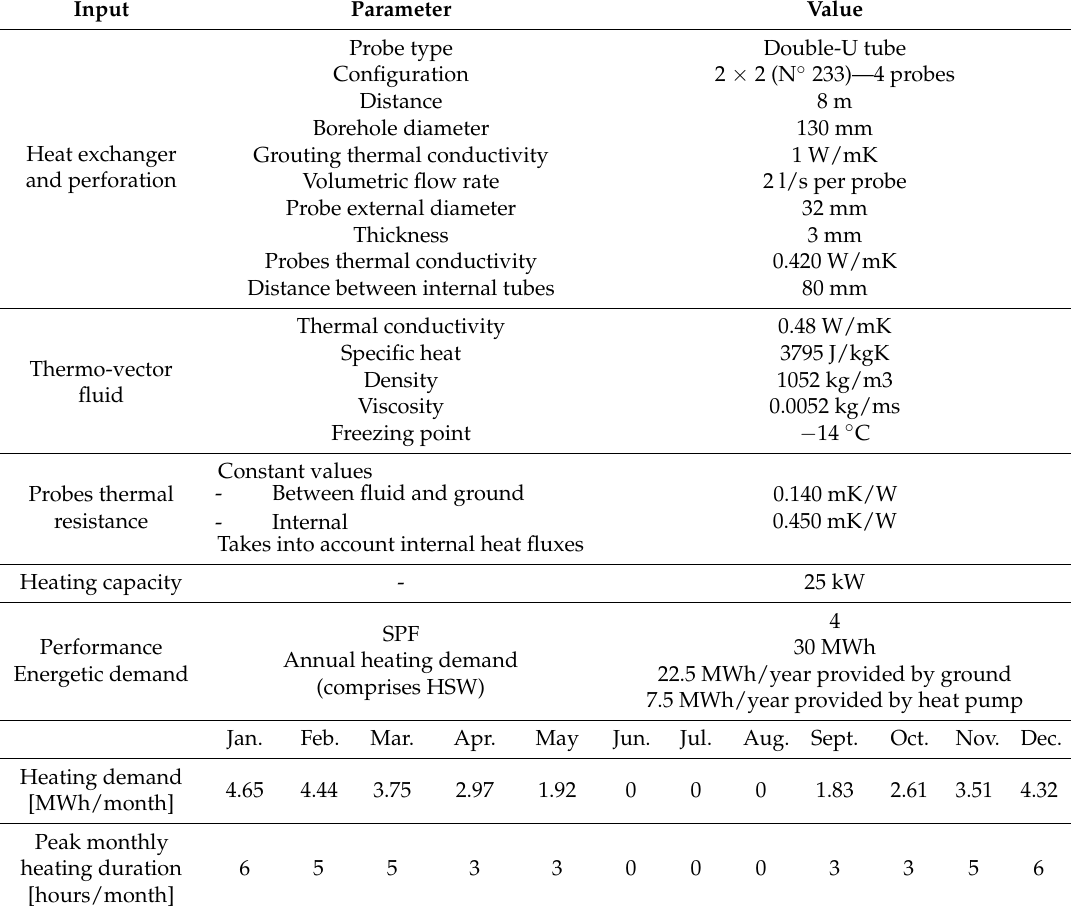
Table 7. Referential geothermal system parameters and values used in earth energy designer (EED)